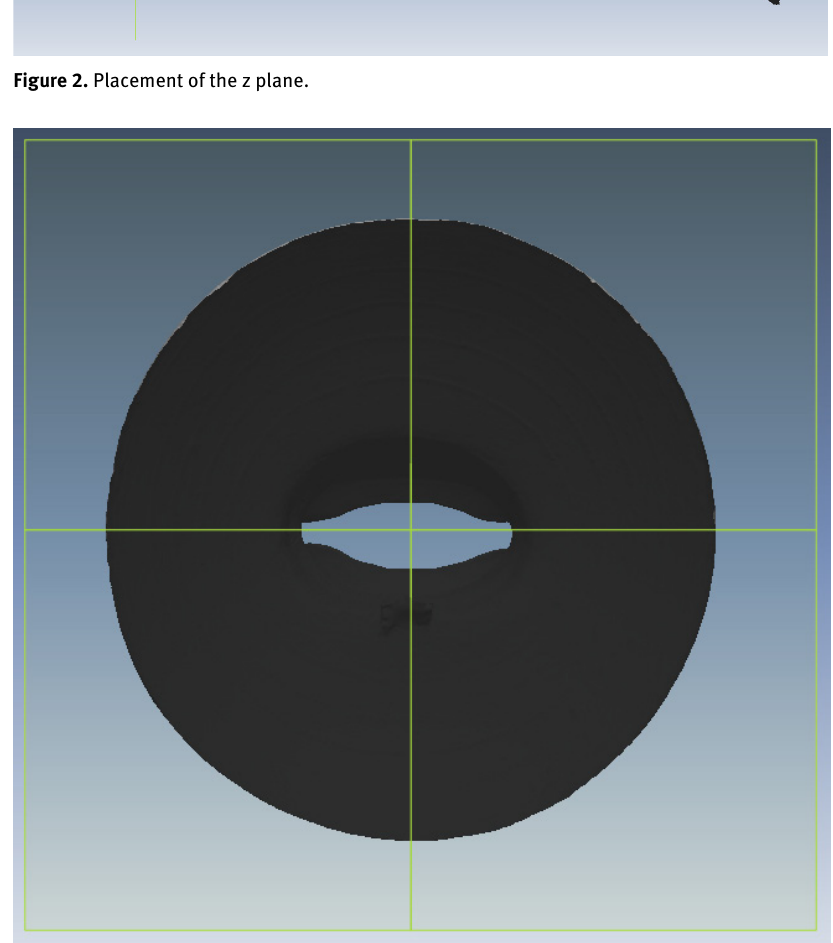
Figure 3. Placement of the x and y